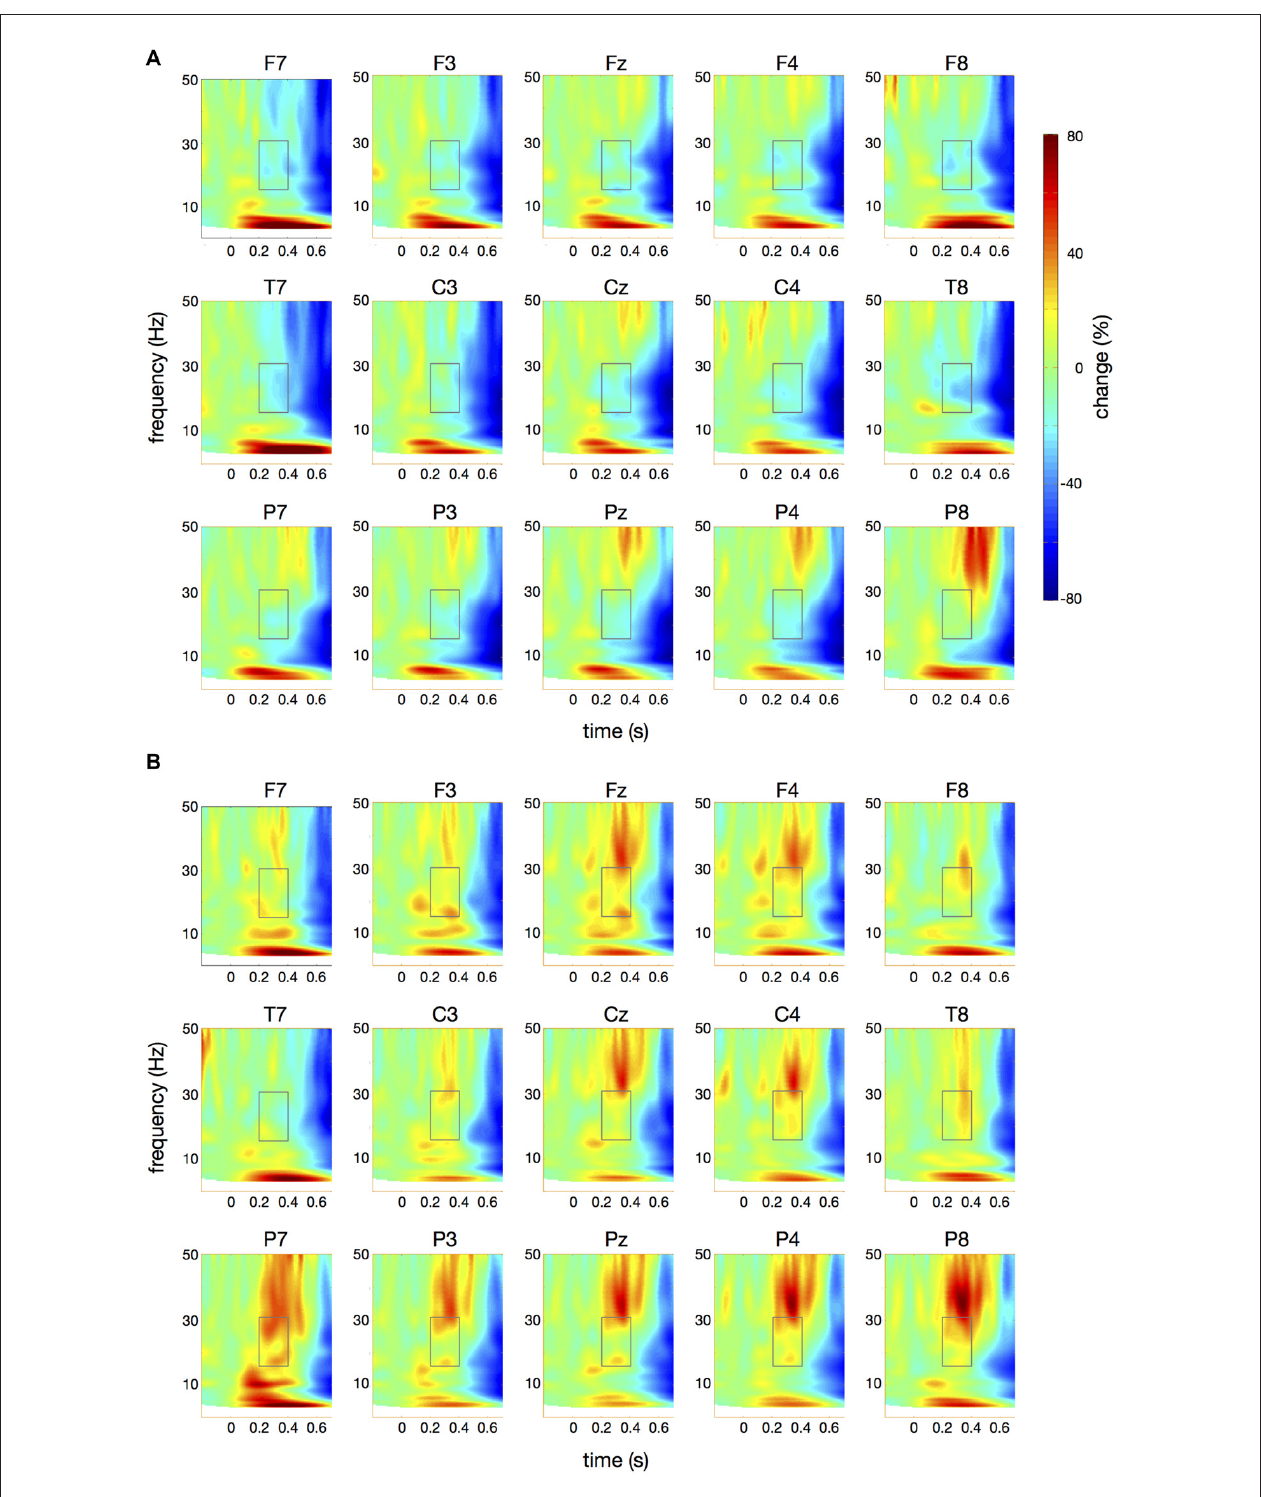
FIGURE 5 | Time-frequency spectra for the pataka condition. The figure represents averaged changes in spectral power relative to a baseline period of − 100 ms to 0 ms during the preparation for speech production. Time (in seconds) is shown on the x -axis; 0 s is the onset of the visual cue ( pataka ). Frequency (1–50 Hz) is shown on the y -axis. Time-frequency spectra are shown for controls (A) and patients (B) . The boxes represent the frequency range (16–31 Hz) and time window (200–400 ms) of the ANOVA.